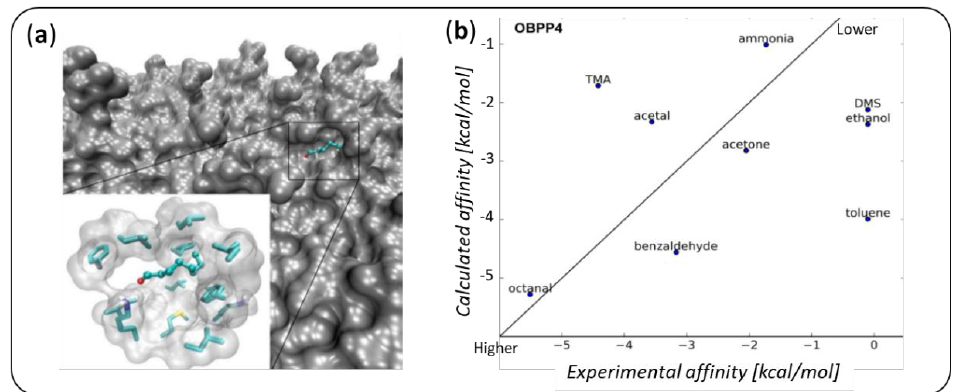
Figure 3. ( a ) Docking simulations performed on an OBP 3D structure model enable to identify a binding site for octanal for obtaining specific peptides accordingly. ( b ) The experimental and calculated affinities are consistent and show that one of the peptides has a high affinity for octanal